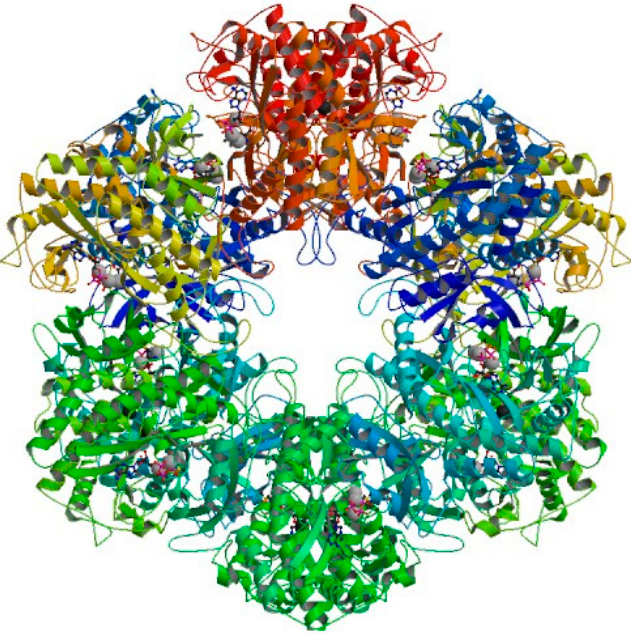
Figure 4. Overall MtGS structure. The active sites represented by a ball-and-stick model of MSO-P and ADP are located at subunit-subunit interfaces.